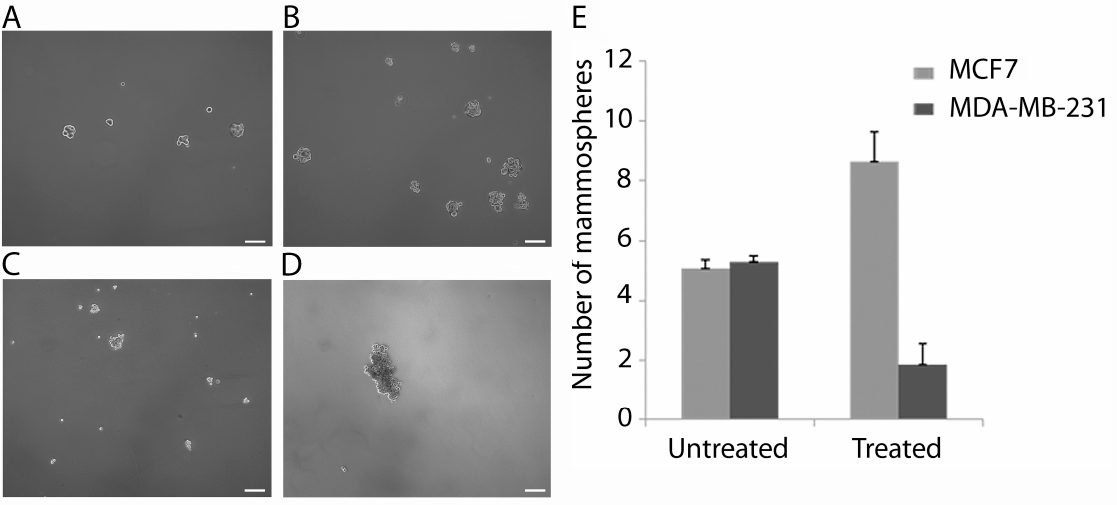
Figure 6. Analysis of impact of CoCl 2 treatment of the mammosphere forming potential of MCF7 and MDA-MB-231 cells. Representative brightfield images of mammospheres from untreated MCF7 ( A ) and MDA-MB-231 ( C ) at day 9, compared with CoCl 2 treated cells of MCF7 ( B ) and MDA-MB-231 ( D ). Images were taken at 5 × magnification and a 100 µ m scale bar is shown. Graphical representation of mammosphere forming assay data, number of mammospheres were counted using brightfield microscopy on day 9 of culture for treated and untreated cells ( E ). Bars represent an average of n = 3 individual experiments for both cell lines. Note the increase in mammosphere forming potential in the treated MCF7 compared to untreated p = 0.02. Note the reduced mammosphere forming potential of the treated MDA-MB-231 compared to untreated control p = 0.008.